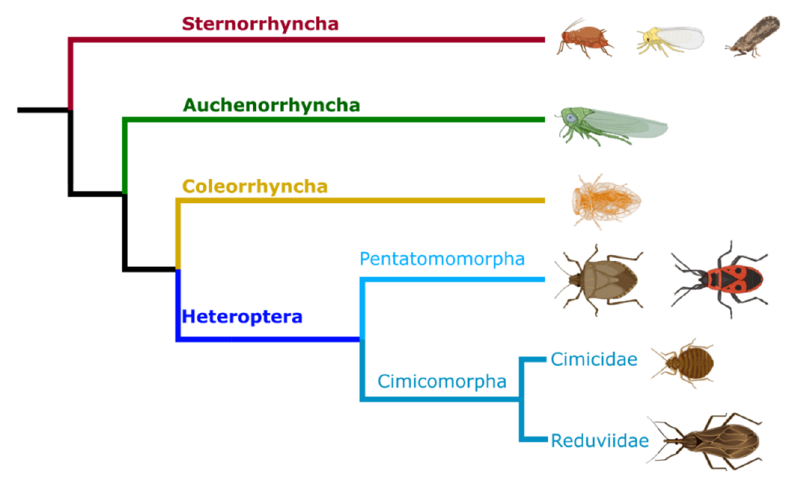
Figure 1. Evolutionary relationships among the four Hemiptera suborders and some selected Heteroptera. Hemipterans are divided taxonomically into four monophyletic suborders: Sternorrhyncha (i.e., aphids, psyllids, and whiteflies), Auchenorrhyncha (i.e., cicadas, spittlebugs, and planthoppers), Coleorrhyncha (i.e., moss bugs), and Heteroptera, (i.e., true tugs). Among the Heteroptera, the infraorders Pentatomomorpha (i.e., stinkbugs and firebugs) and Cimicomorpha (i.e., bed bugs, and triatomines) present symbioses with extracellular GI tract bacteria. Phylogenetic relationships were drawn based on [81,82].